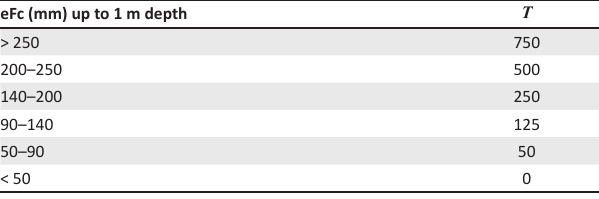
TABLE 5: Values of lithology in the